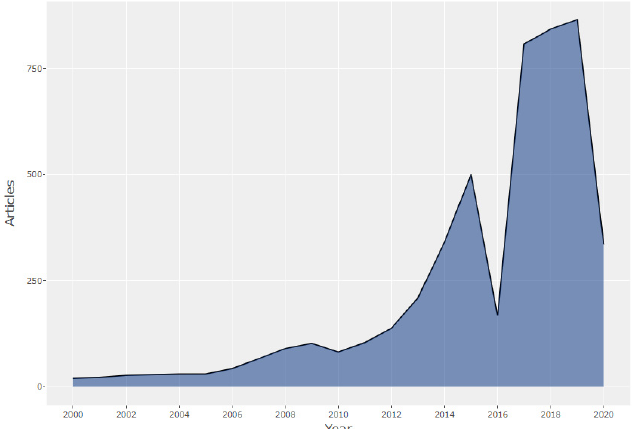
Figure 2. Evolution of production in the field.